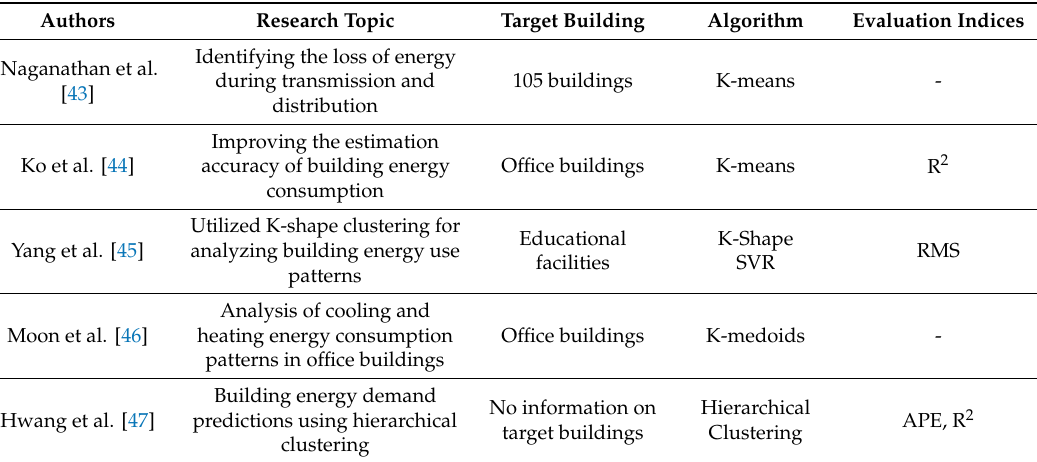
Table 3. Building energy analysis using the clustering